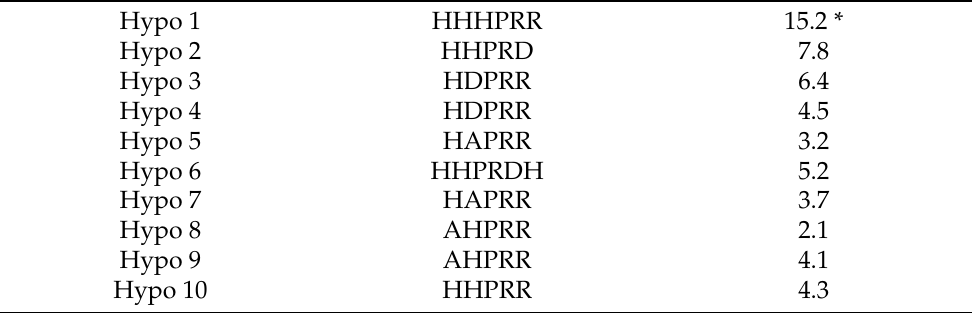
Table 4. Summary of the 10 best pharmacophore models (i.e., Hypo 1–10).